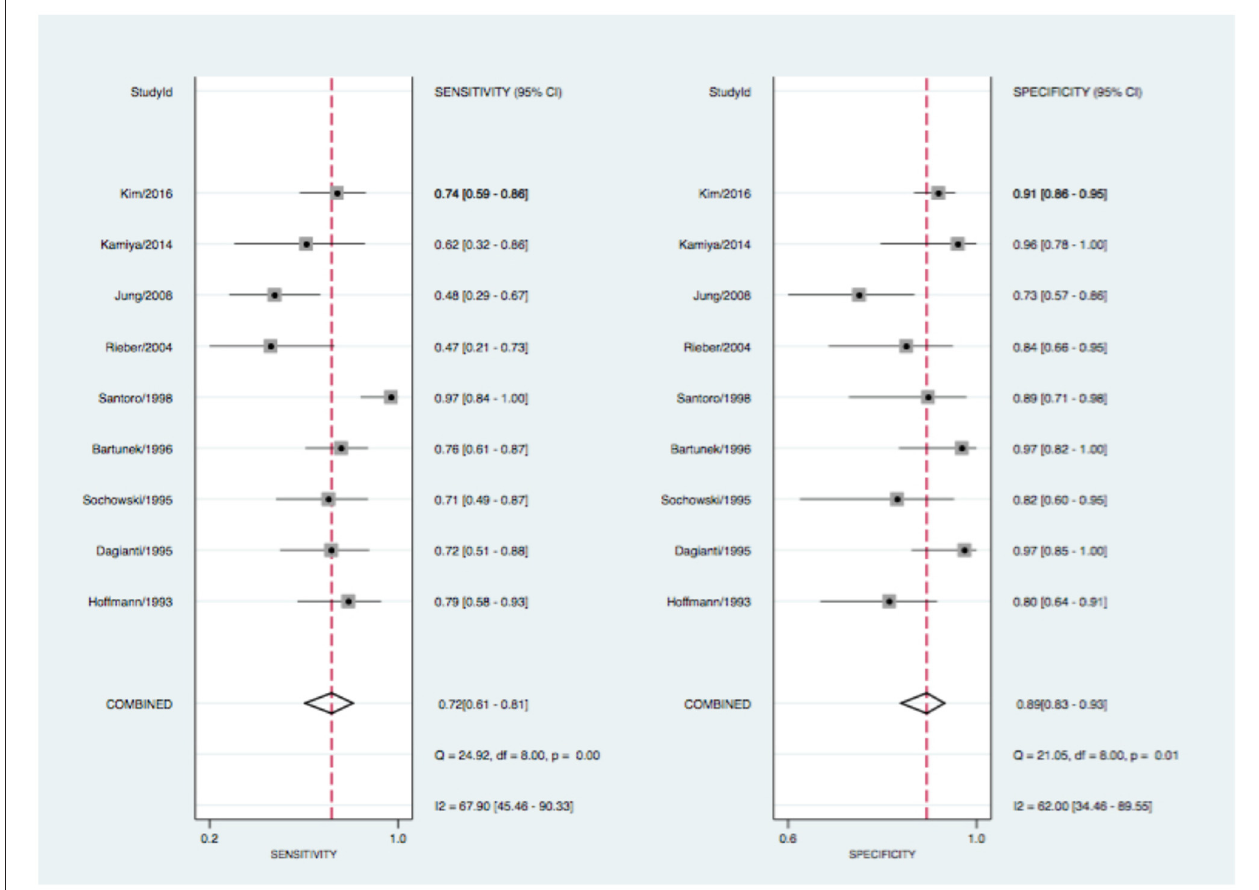
FIGURE 3 | Forrest plot for DSE with sensitivity (left) and specificity (right) estimates. CI, confidence intervall; I 2 , the percentage of variation across studies that is due to heterogeneity rather than chance; Q, Cochran’s Q measure of